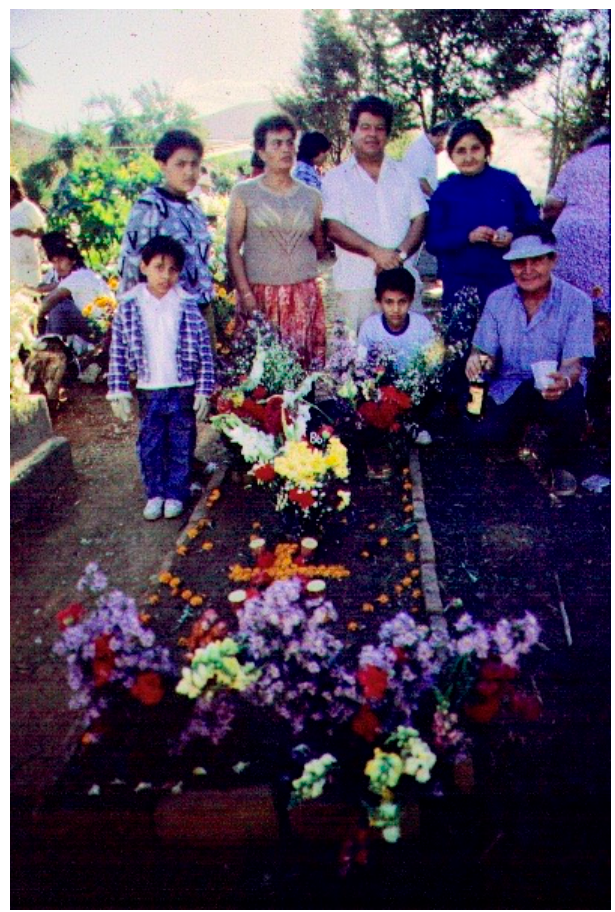
Figure 2. Family beside the grave of their difunto in El Marquesado. Cemetery, Oaxaca de Juárez, Oax., 1989 (photo by author). Oax., 1989 (photo by